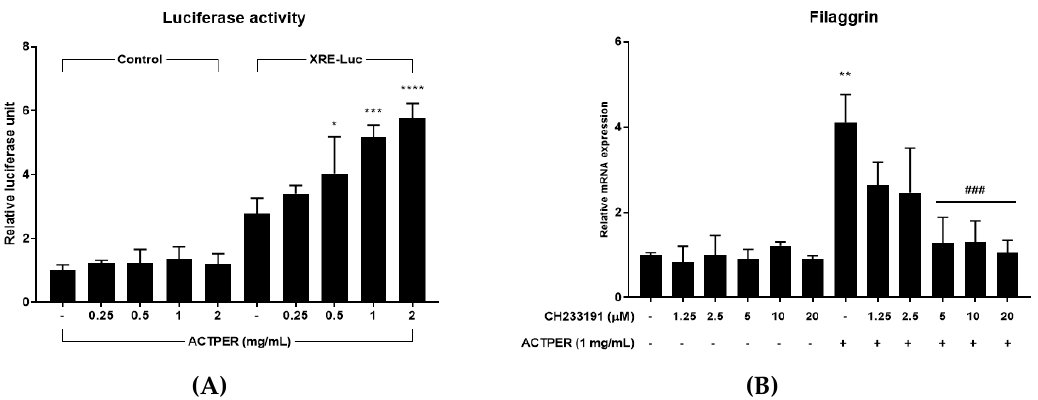
Figure 6. Effects of ACTPER on filaggrin expression were mediated by the aryl hydrocarbon receptor (AhR) signaling pathway. ( A ) Luciferase activity was measured; ( B ) Changes in the RNA level of filaggrin. Values represent the mean ± S.E.M. of three independent experiments. * p < 0.05, ** p < 0.01, *** p < 0.001, **** p < 0.0001 compared with control group; ### p < 0.001 compared with ACTPER treated group.